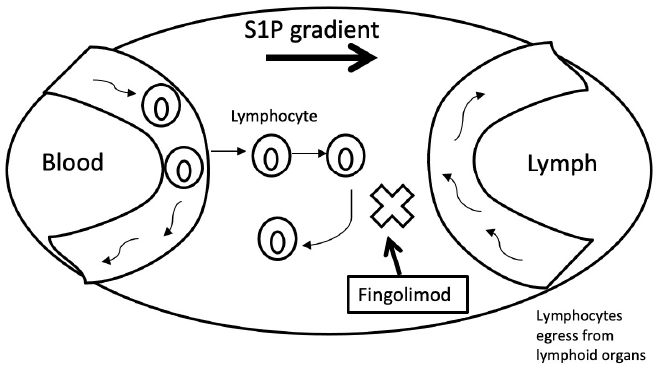
Figure 4. Mechanism of action of fingolimod.